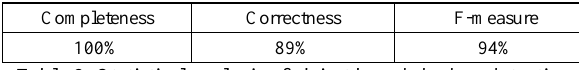
Table 3: Statistical analysis of object-based shadow detection To evaluate the performance of proposed disparity map refinement method, 260 corresponding points are measured manually. The disparity value of measured points was compared to the disparity computed by SGM algorithm and the proposed method. Evaluation results for both results are presented in Table 4.